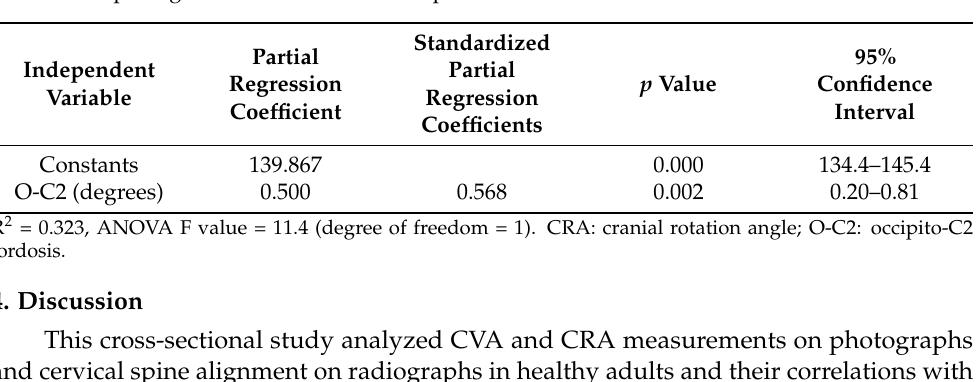
Table 5. Simple regression for CRA as the dependent